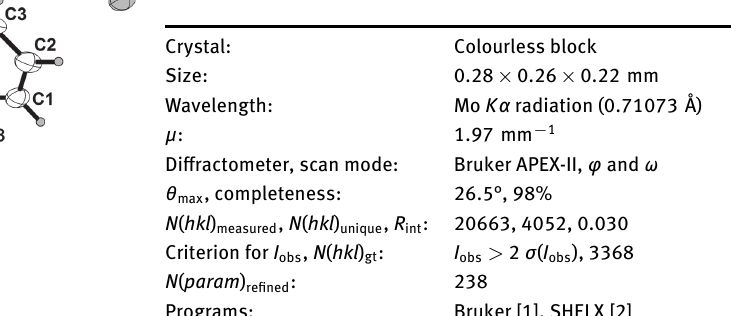
Table 1: Data collection and handling.